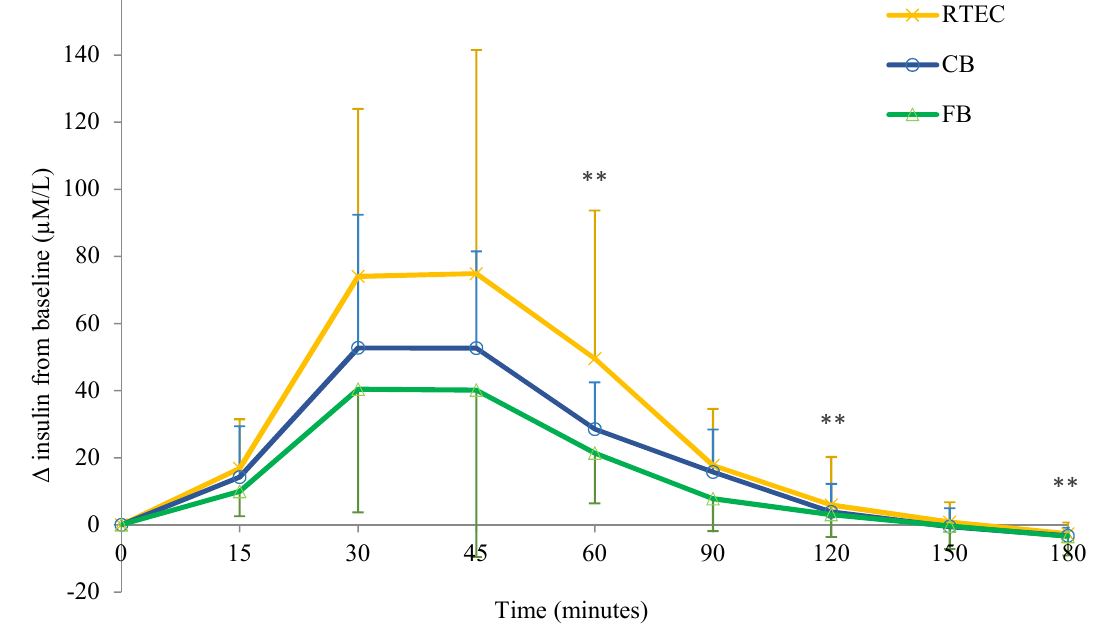
Figure 4. Change from baseline in insulin response (IR) in n = 16 adults following consumption of CB (control breakfast), FB (functional breakfast) and RTEC (ready-to-eat cereal). Values are means ± SD. ** p < 0.05.